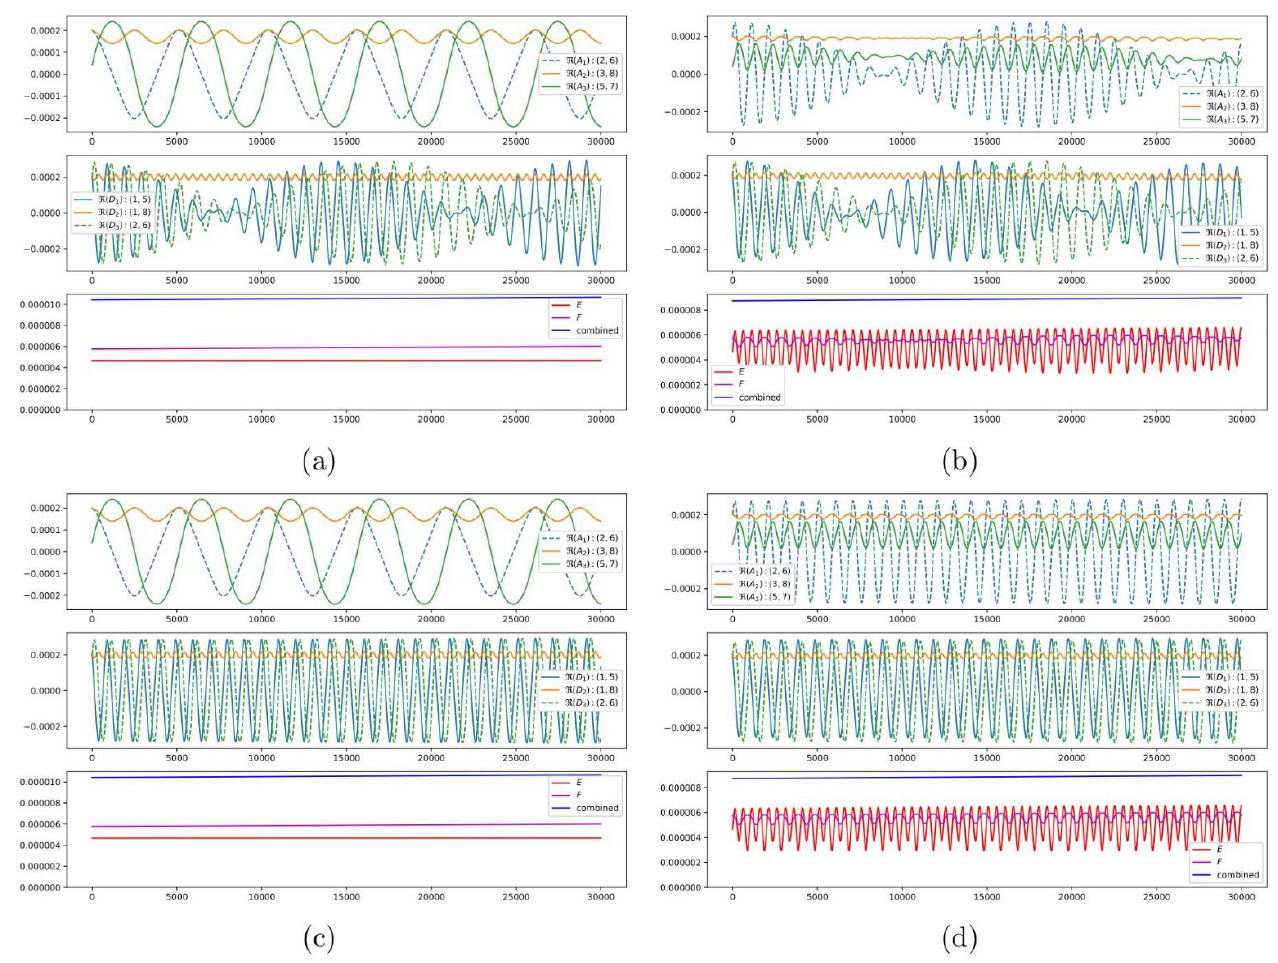
Figure 6. Color online. Each panel shows the time evolution of (top) the amplitude of the modes in the resonant triad; (middle) the amplitude of the modes in the detuned triad; (bottom) the energy E of the resonant triad, the energy F of the detuned triad and the total energy. The panels are as follows: ( a ) uncoupled with physical detuning δ = 0.000396825; ( b ) coupled with physical detuning; ( c ) uncoupled with zero detuning; ( d ) coupled with zero